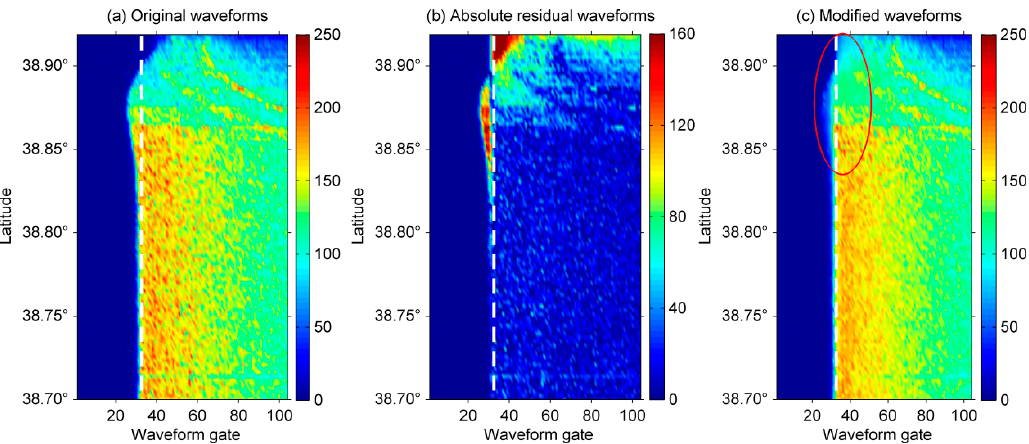
Figure 2. Failed case of coastal waveform modification illustrated by Jason-2 pass #228, cycle #50, near Cape May, NJ, USA. White dashed line shows the nominal tracking gate. The upper boundary in latitude indicates the coastline. Waveforms along with latitude are color-coded by waveform sampling power. ( a ) Original waveforms; ( b ) Absolute residual waveforms relative to the mean waveform over 20–30 km offshore; ( c ) Modified waveforms.